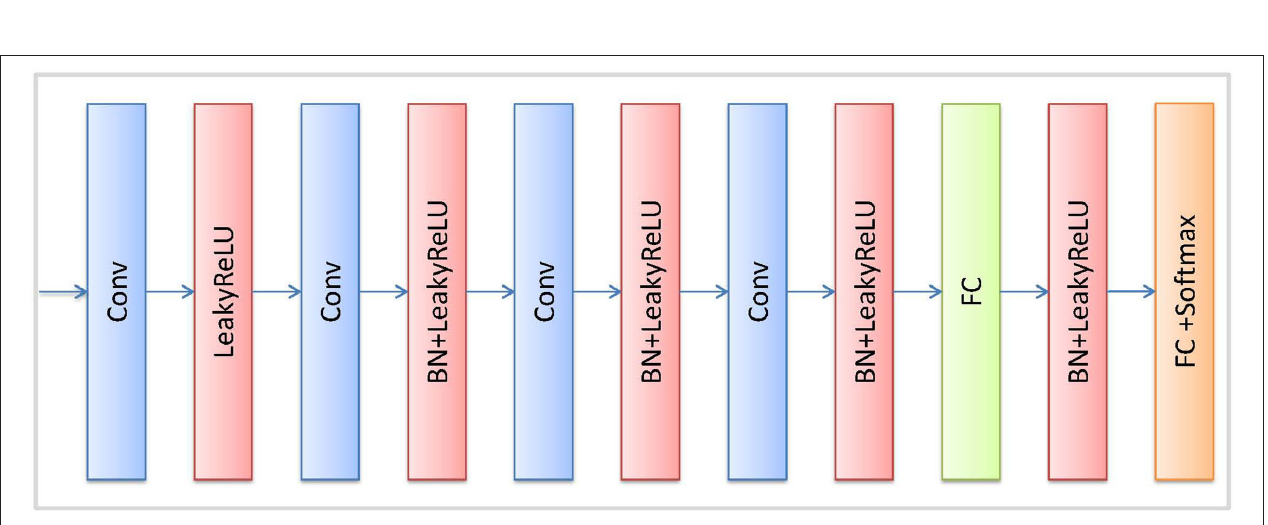
FIGURE 3 | Detailed architecture of discriminator